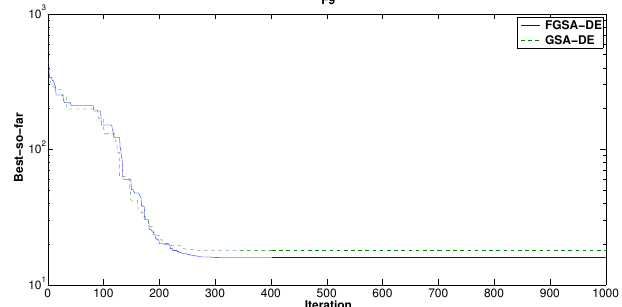
Figure 11. Comparison of the performance of FGSA-Differential Evolution (DE) and GSA-DE for minimization of F 4.